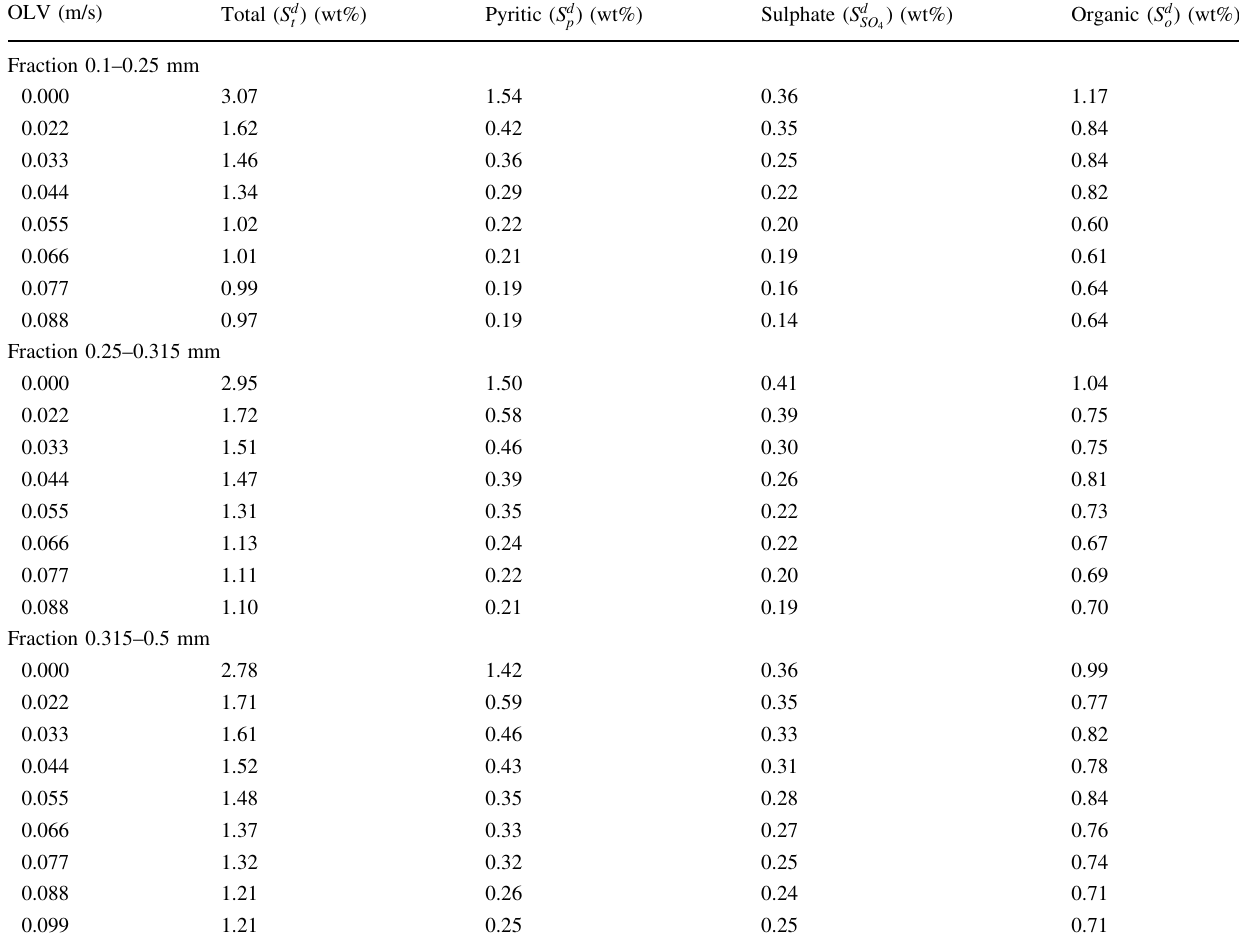
Table 10 Sulphur content in desulphurized coal OLV